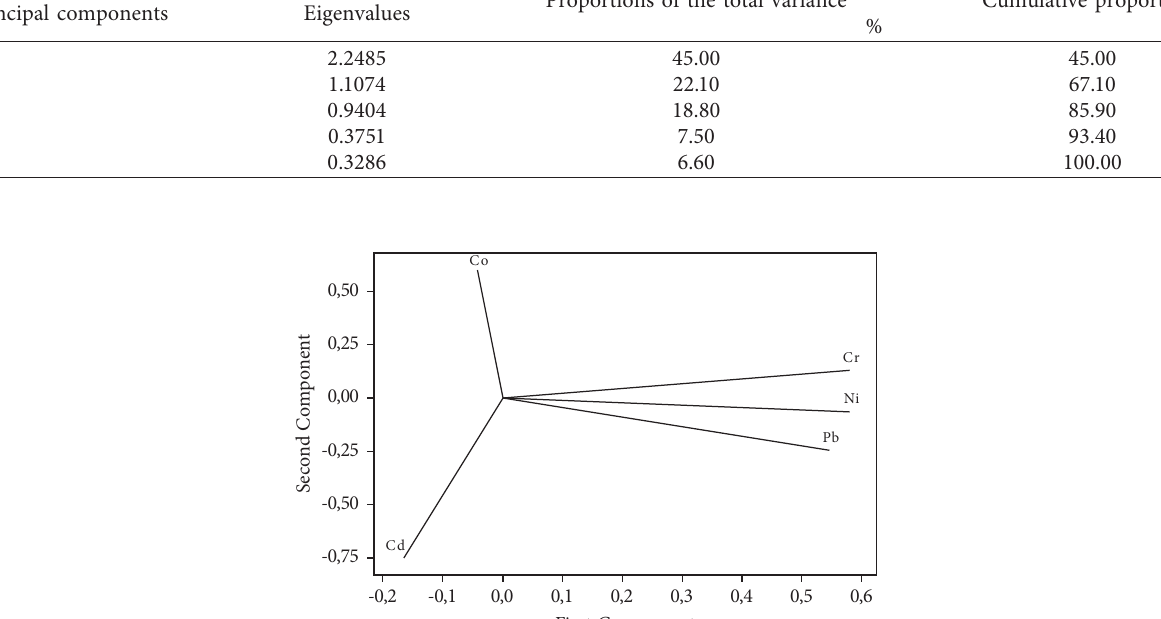
Table 3: PCA results of heavy metal concentrations in the soil of shallot fields in Brebes Regency, Central Java, Indonesia. Principal components